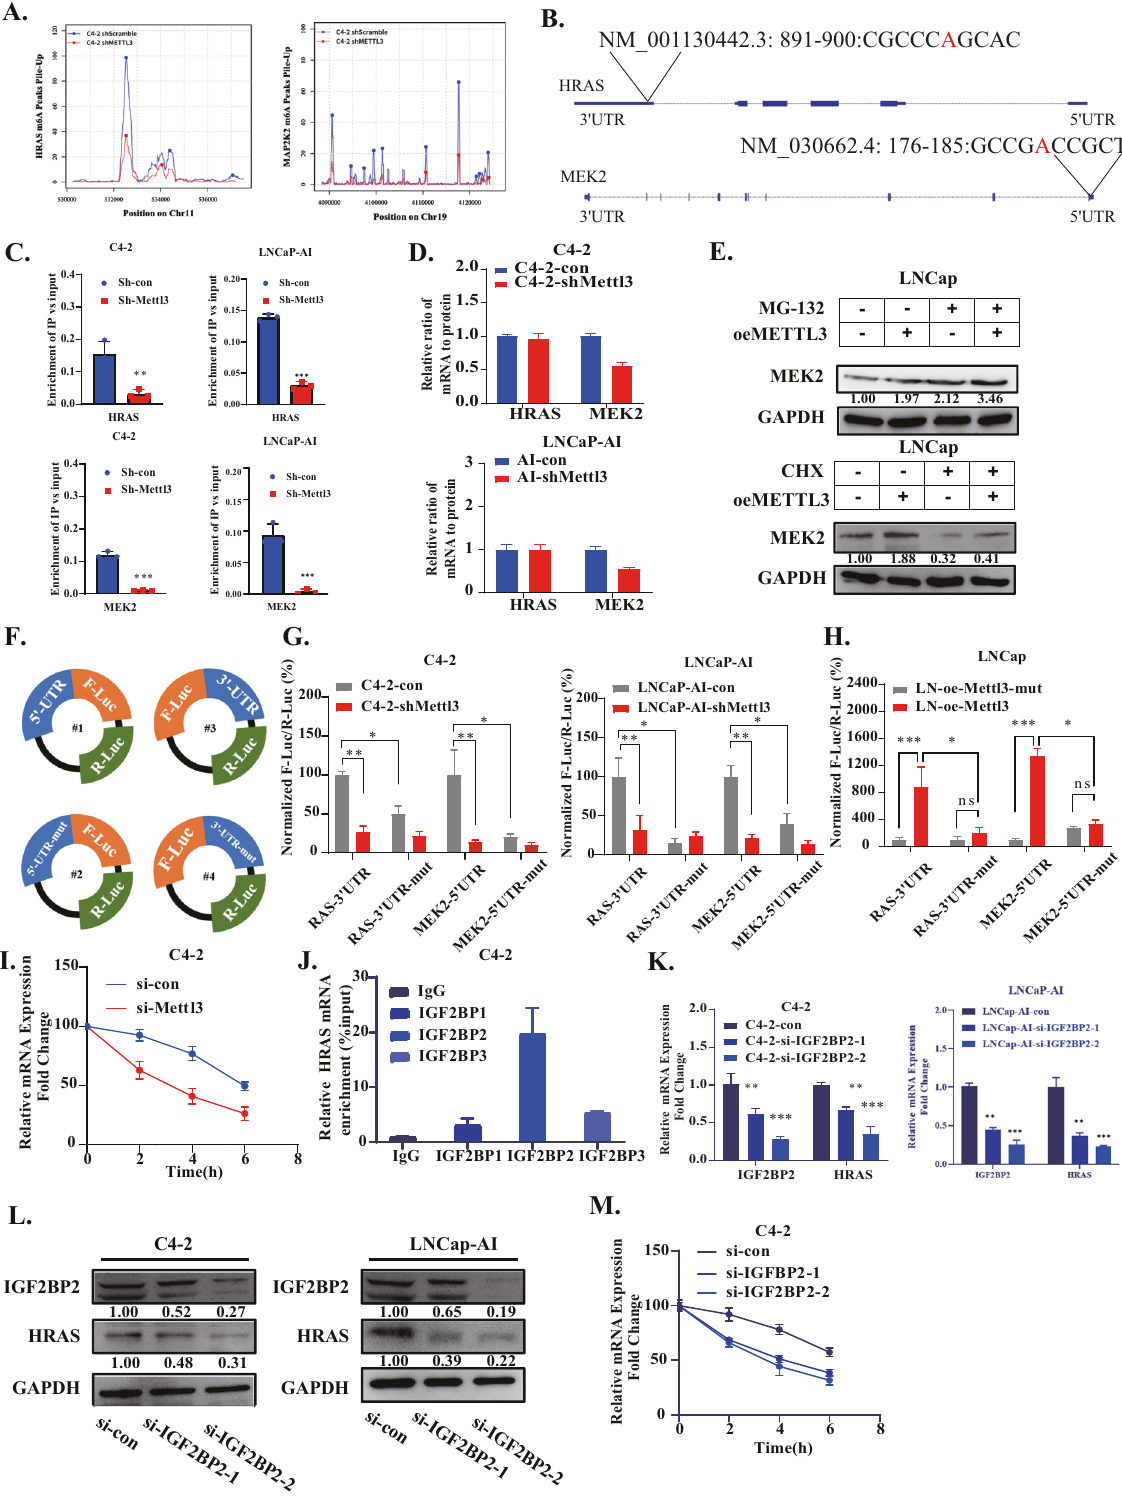
enhancing the invasion ability of cancer [56]. In gastric cancer, m 6 A modi fi cation activated the ERK pathway by inhibiting BATF2 [57]. Furthermore, it has been reported that ERK can mediate the phosphorylation of METTL3 and regulate its stability [58]. Although the relationship between METTL3 and the ERK